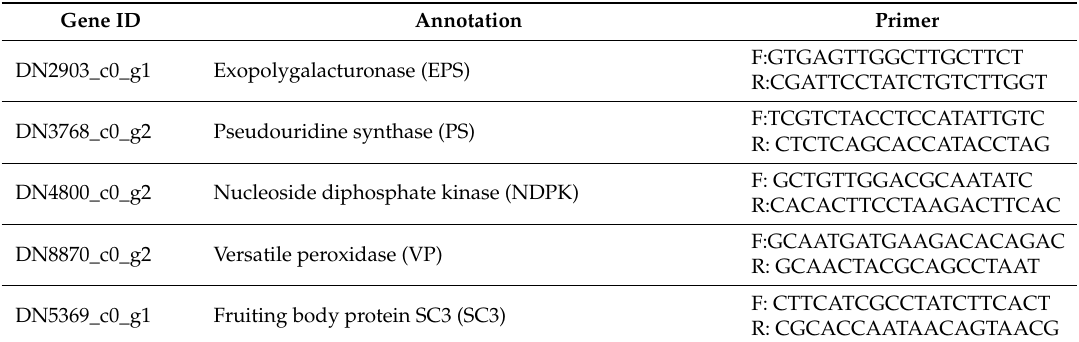
Table 1. Primers for qRT-PCR of 12